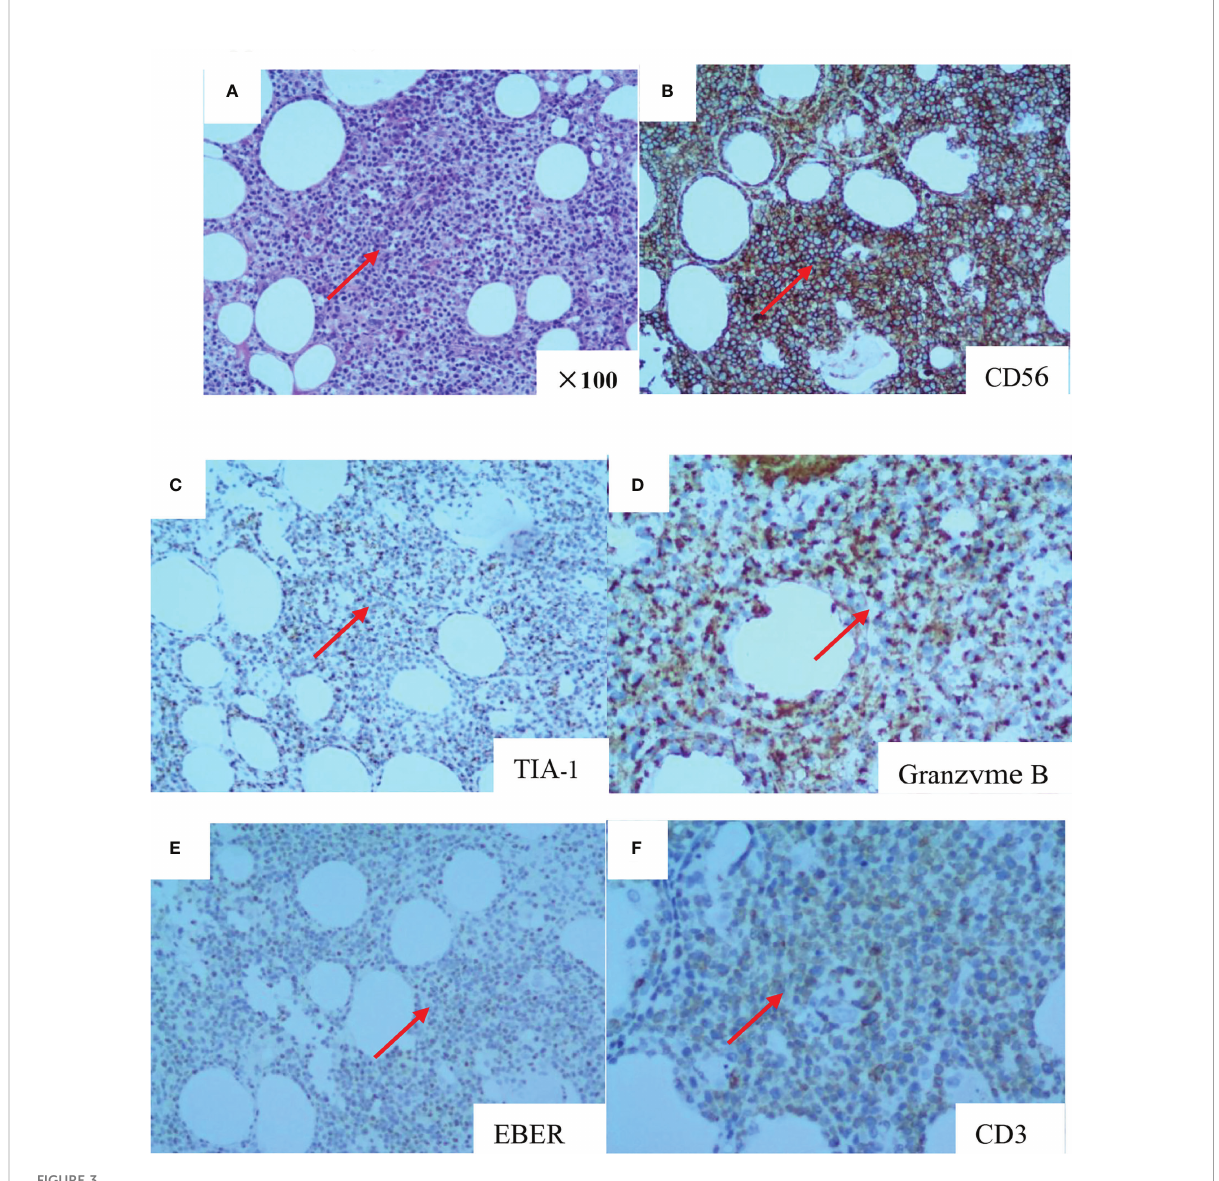
FIGURE 3 The pathology of subcutaneous nodule biopsy suggested diffuse in fi ltration of heterogeneous lymphoid cells in adipose tissue (HE stains, original magnifcation×100) (A) . CD56 (diffuse and strong +) (B) . TIA-1 (+) (C) . Granzyme B (+) (D) . EBER (partial +) (E) . CD3 (+) (F)